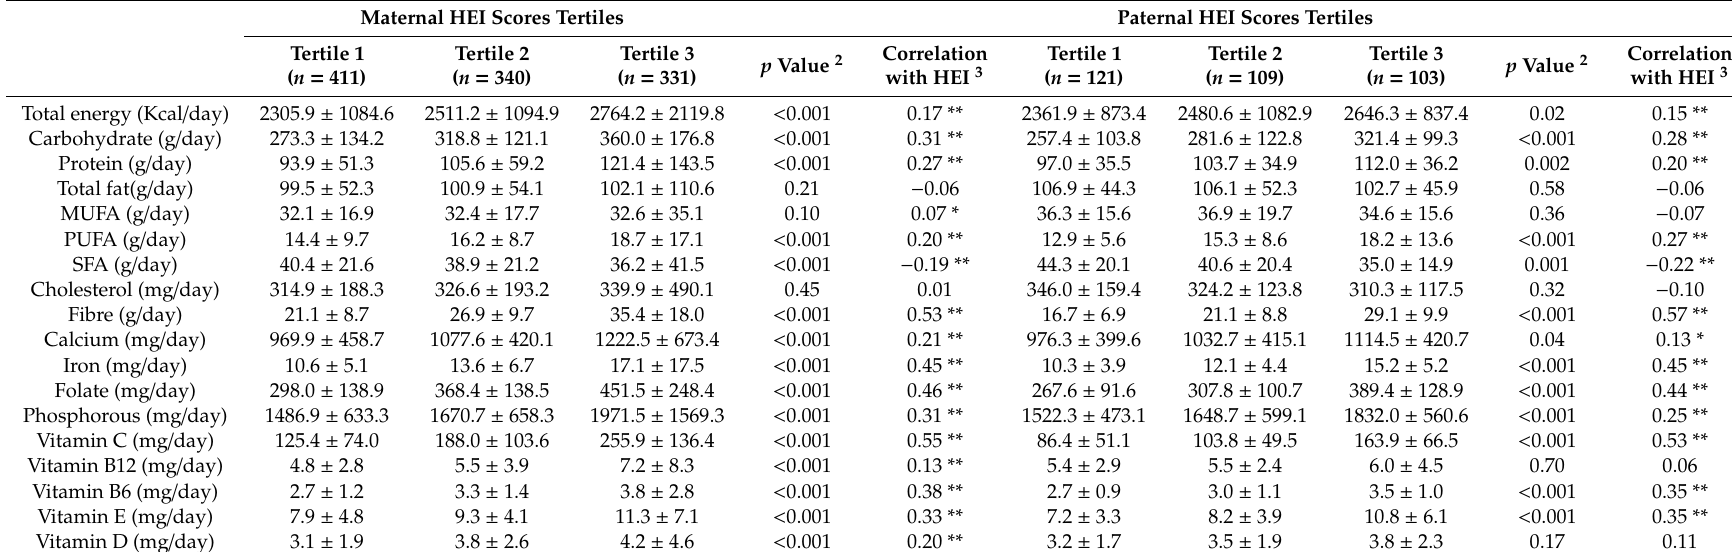
Table 2. Parental nutrient intakes according to tertiles of HEI scores 1